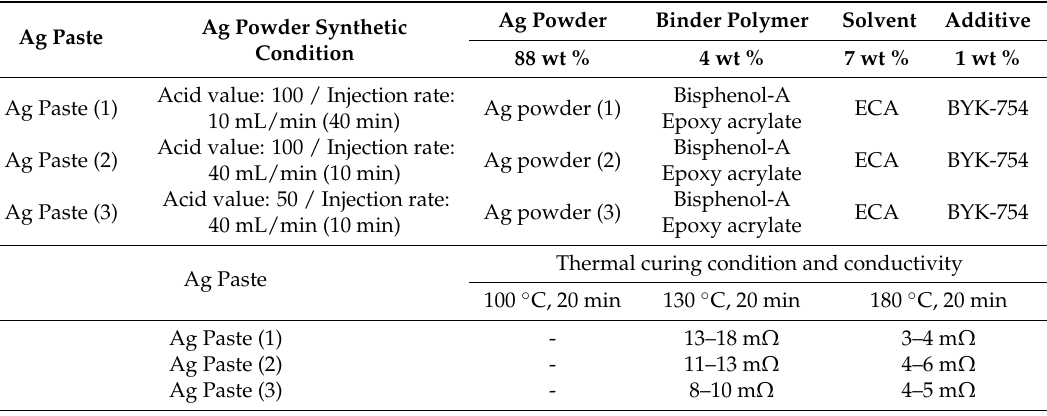
Figure 5. Field emission scanning electron microscopy (FE-SEM) images of synthesized Ag nanoparticles in Ag pastes ( 1 ) to ( 3 ). Table 2. Synthetic condition of Ag nanoparticles and the formulation of Ag nanoparticle pastes. ECA: Diethylene glycol monoethyl ether acetate.